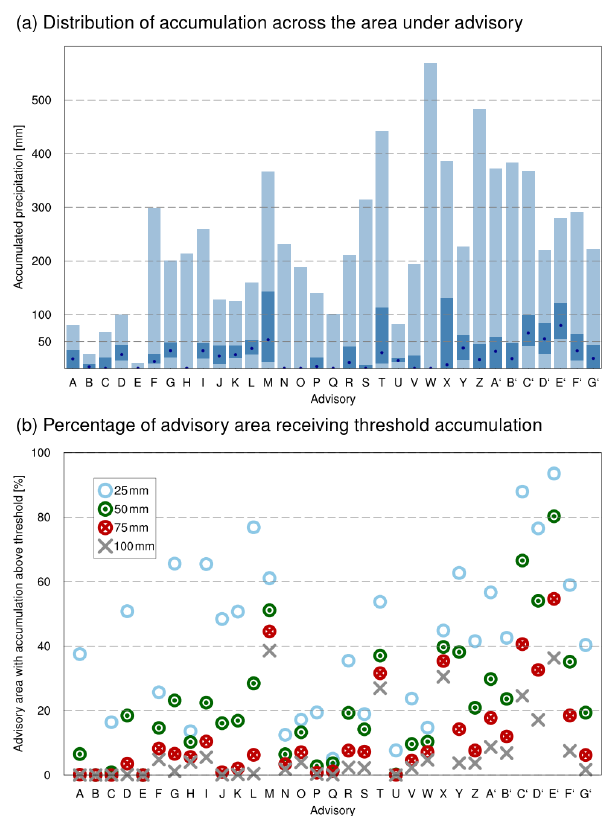
Figure 4. How much rain fell in counties under advisory? (a) Rain- fall accumulation during advisory window, showing distribution over all 5km square grid points within counties mentioned in ad- visory (light/dark shading shows the range/interquartile range of the distribution, and the dot indicates the median). (b) Percentage of each advisory region where rainfall accumulation was above 25, 50, 75, or 100mm.